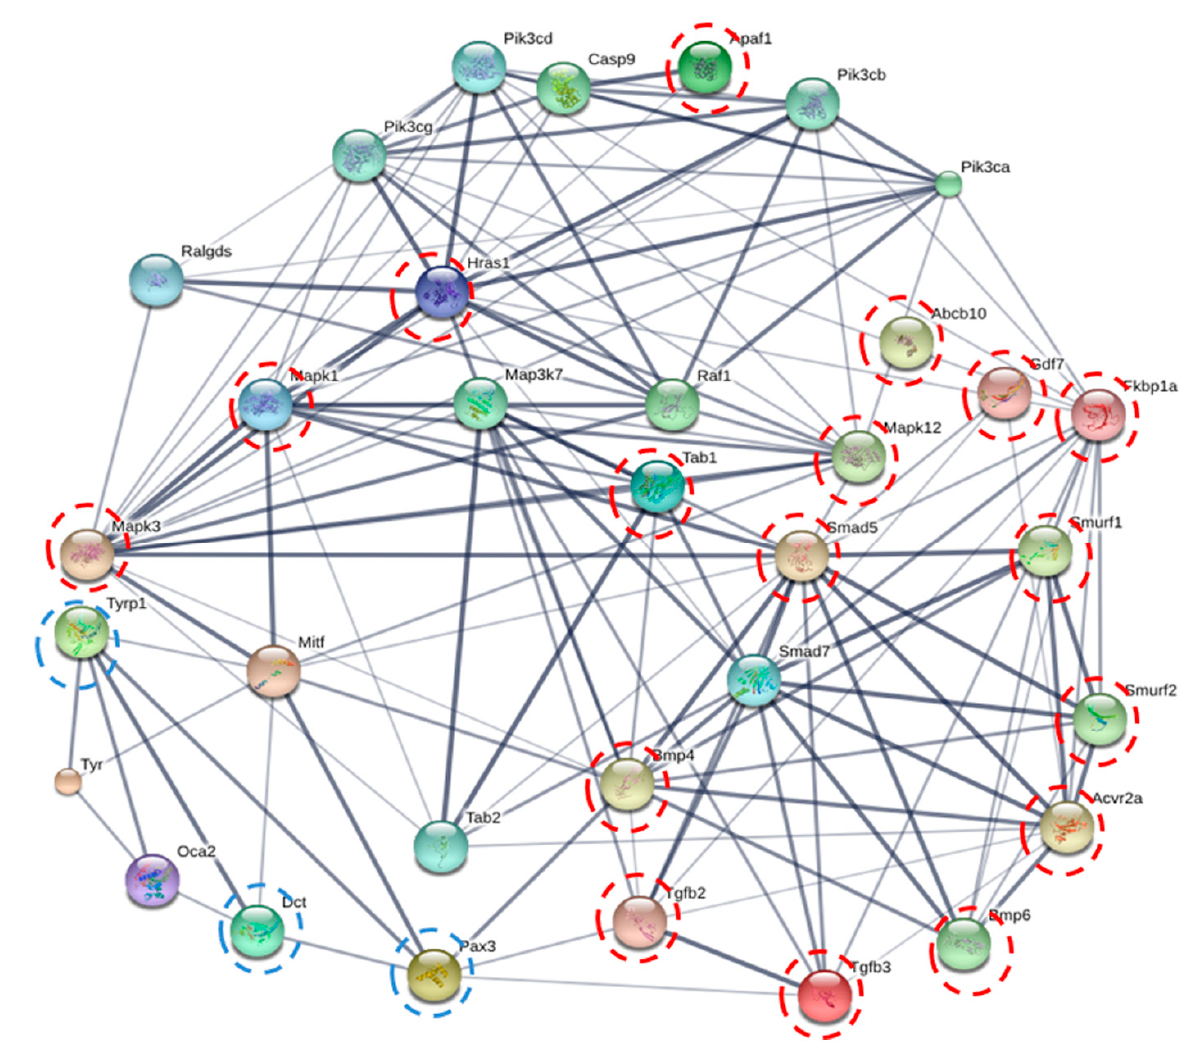
Figure 9. Protein–protein interactions by STITCH. The interactive networks of 17 proteins in the TGF- β signaling pathway and their predicted association with proteins in melanogenesis. The red dashed line circles indicate the proteins in the TGF- β pathway, which directly interact with the melanogenesis proteins. The blue dashed line circles depict the proteins in melanogenesis from the proteomics dataset.